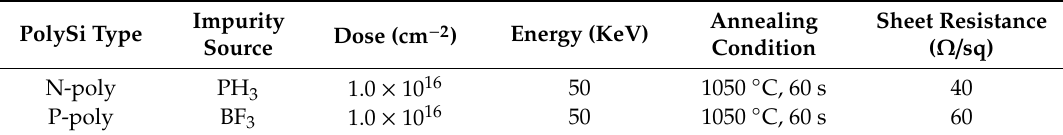
Table 1. Injection and annealing conditions of Table 2. Etch conditions of polysilicon.